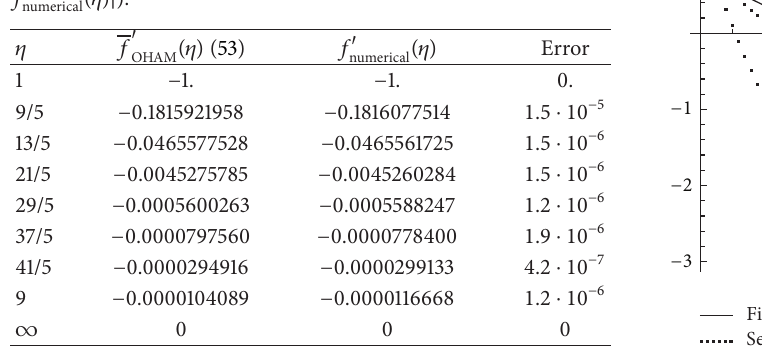
󸀠 (𝜂) obtained from 󸀠 (𝜂)− OHAM